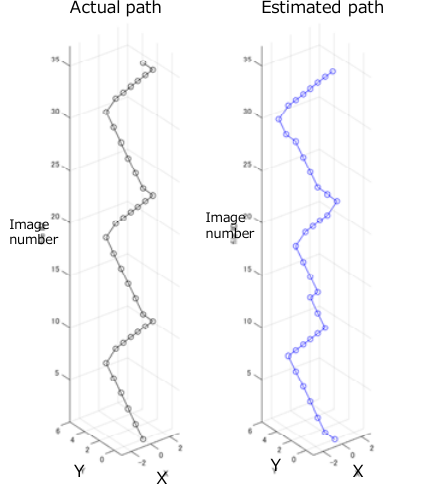
Figure 11. Camera translation estimation result, Stairs (Left image: actual camera path, right image: our estimated result)